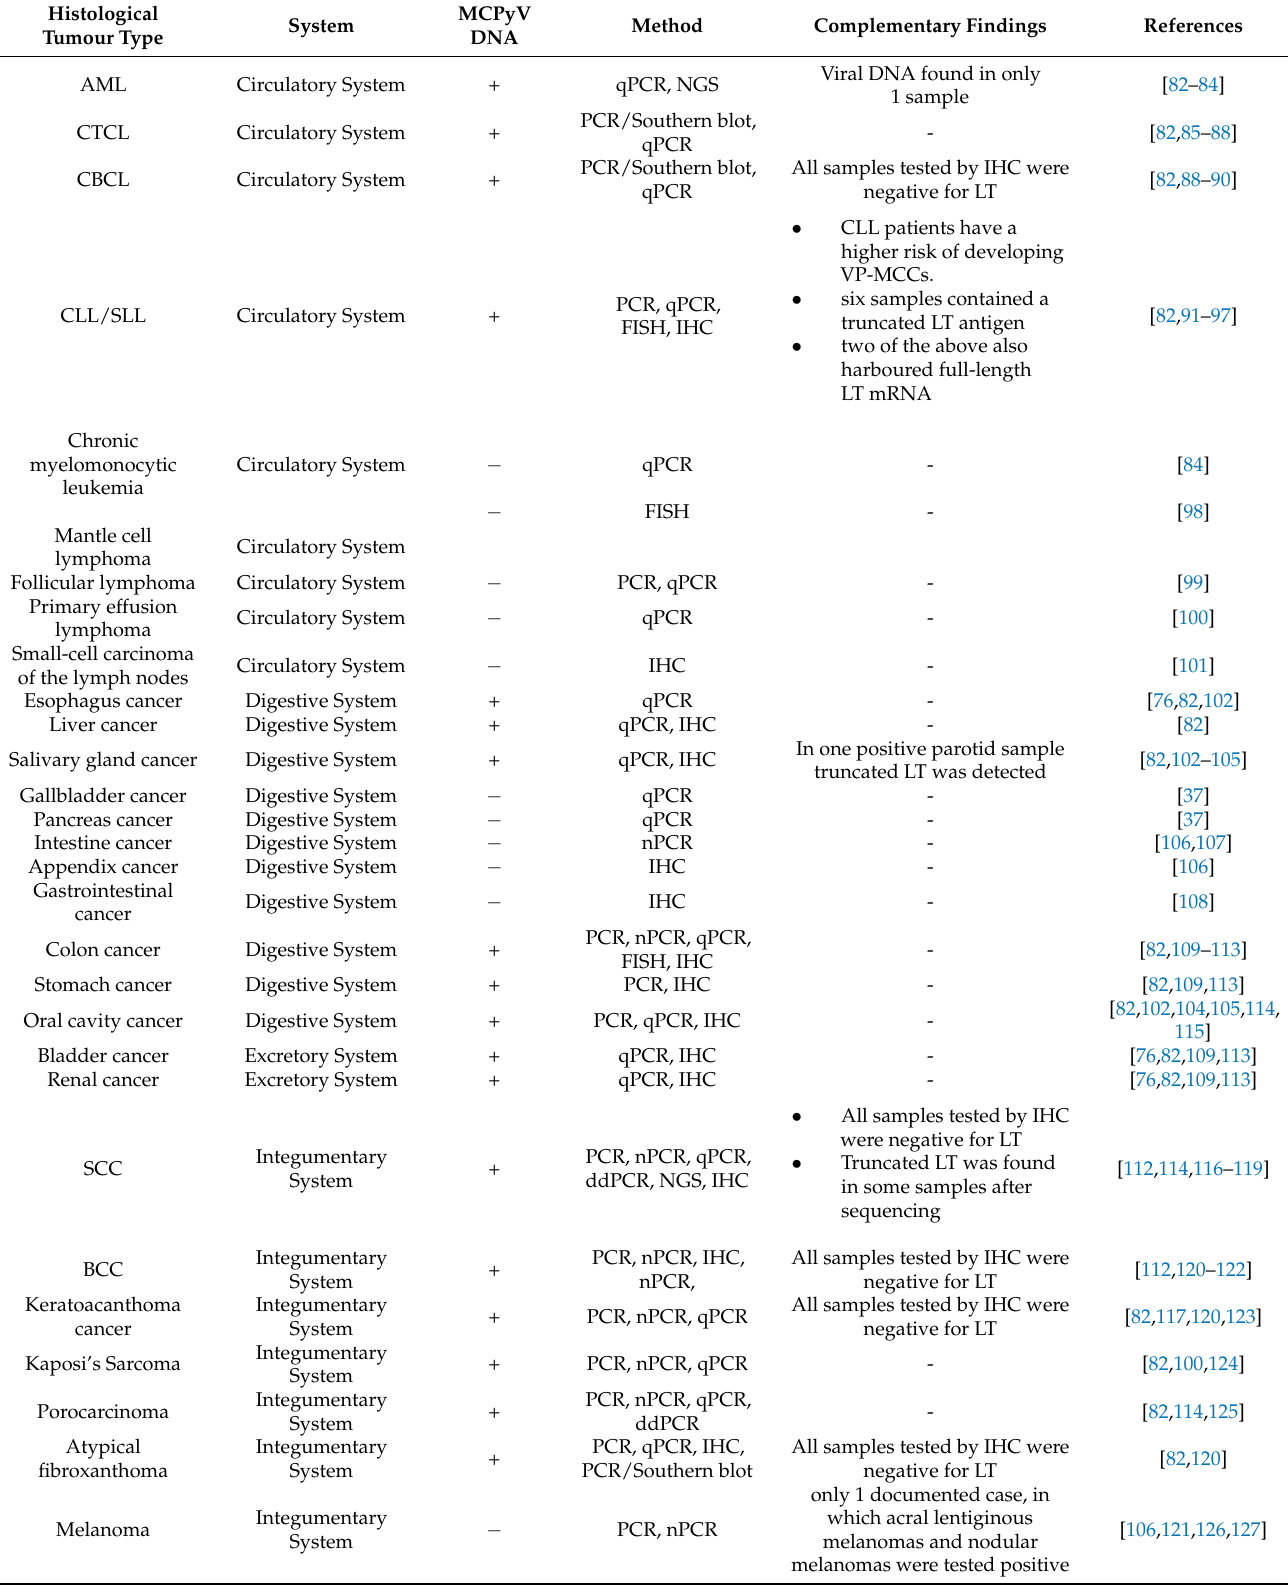
Table 1. Detection results and method of the MCPyV DNA in tumours derived from different tissues. For the positive cases of the same type of tumours tested, the prevalence of the viral DNA varies